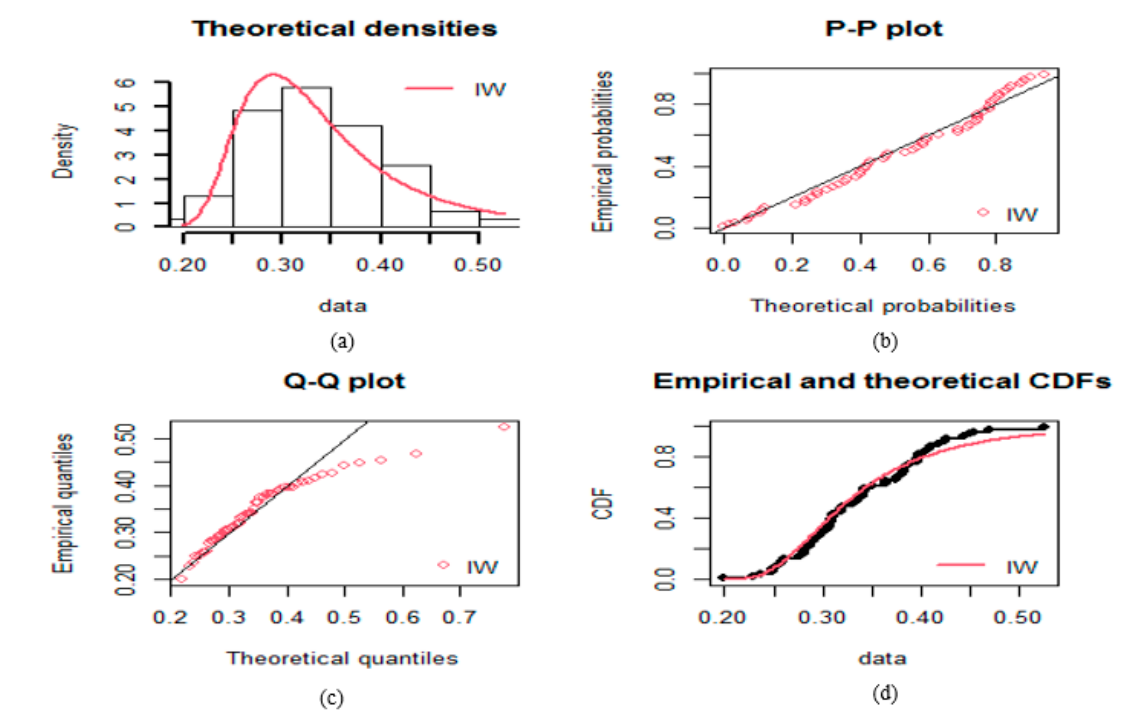
Figure 2. Examples of fits of IWD for the Stress (Y) dataset: ( a ) histogram fitted by the estimated pdf, ( b ) empirical cdf fitted by the estimated cdf, ( c ) P-P plot, and ( d ) Q-Q plot.